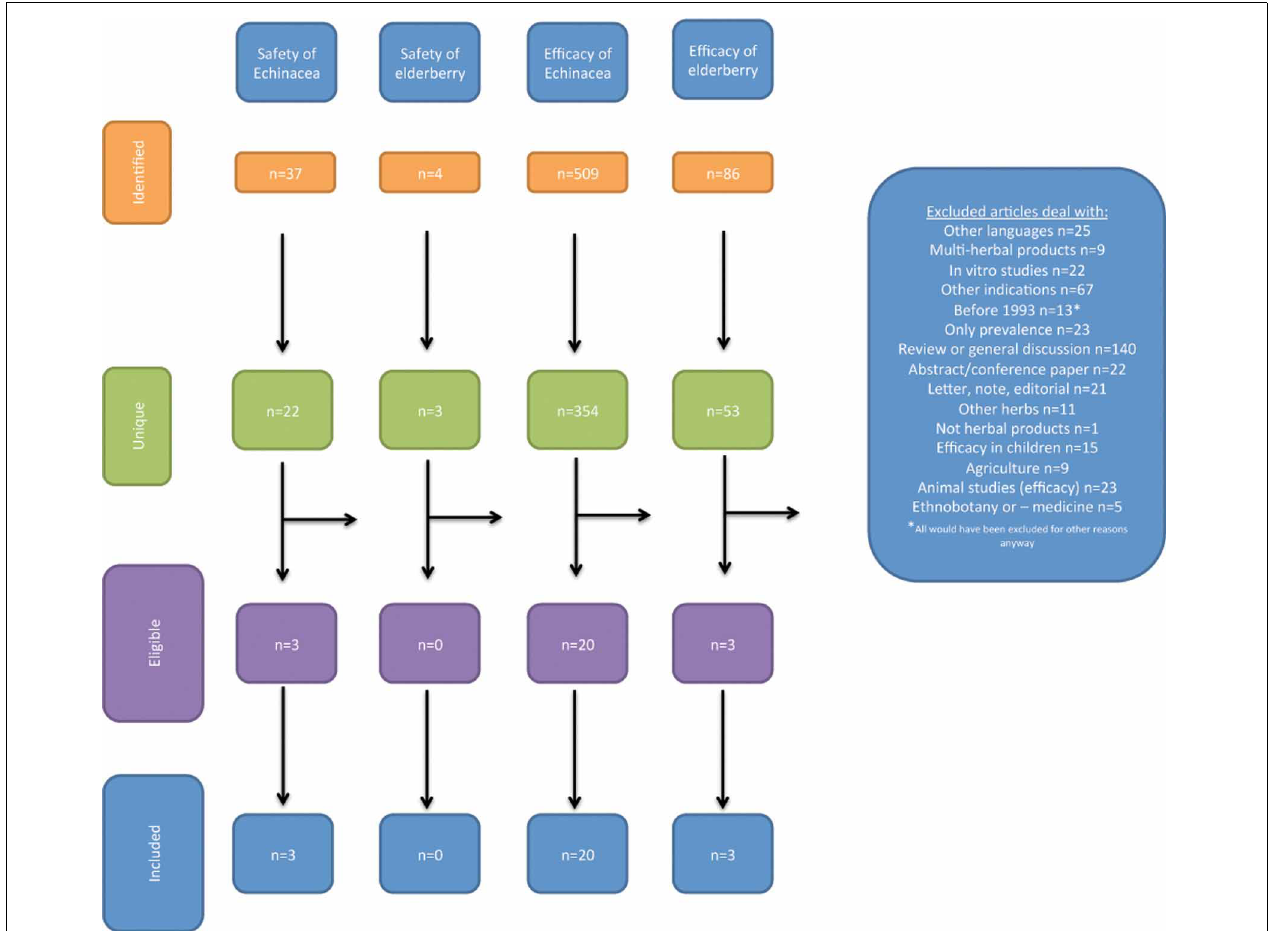
FIGURE 1 | Identification of the studies included in the